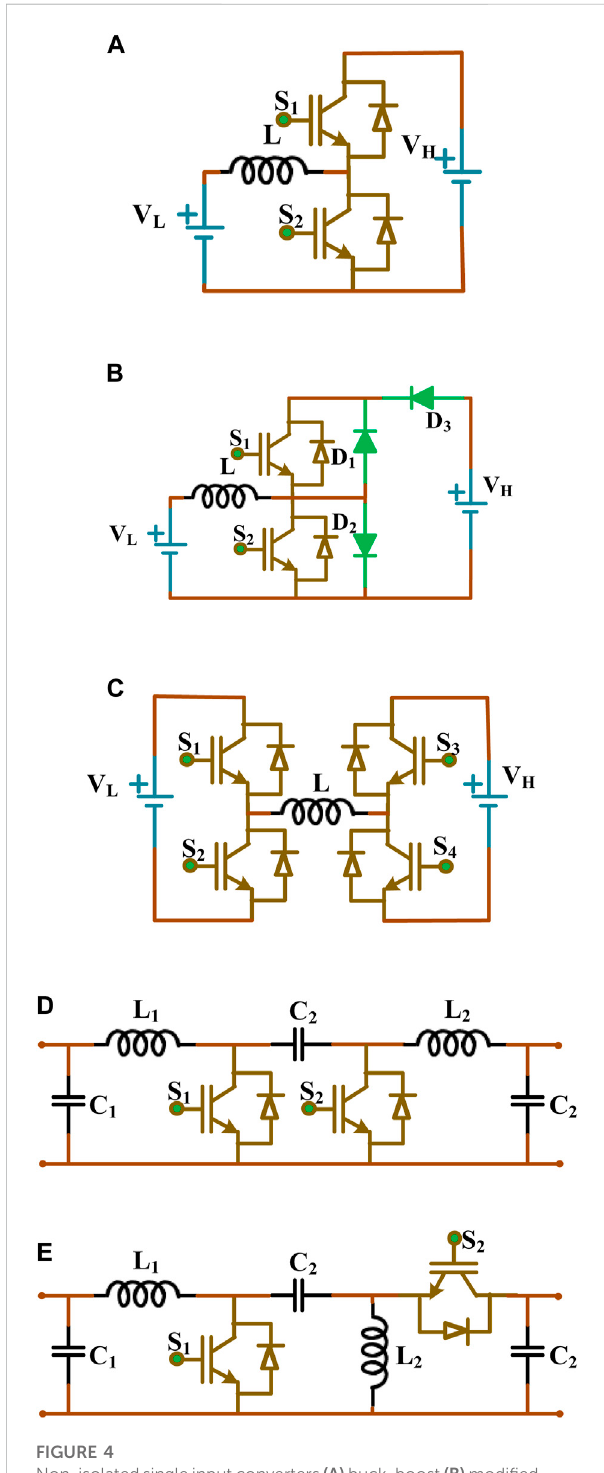
FIGURE 4 Non-isolatedsingleinputconverters (A) buck-boost (B) modi fi ed buck-boost (C) H-bridge (D) CUK (E) SEPIC with